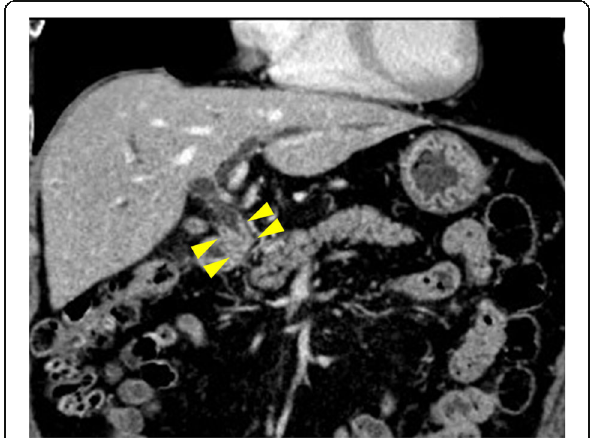
Fig. 1 Enhanced wall thickening from the middle to the distal portion of the common bile duct (arrow) without any enlarged regional lymph nodes was detected by enhanced CT (coronal section image)